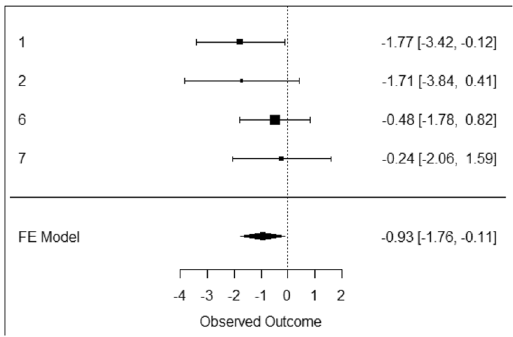
Fig. 5 Effect meta-analysis of image framing effect. Meta-analysis of Framing ’ s coef fi cient estimates on assignment of secondary emotions to refugees across Studies 1, 2, 6, and 7 con fi rming that on average dehumanization of refugees was greater after exposure to pLG than to pSG Cook ’ s distances and studentized residuals showed no indication of outliers in and the Q -test and I 2 suggest no evidence of heterogeneity in this